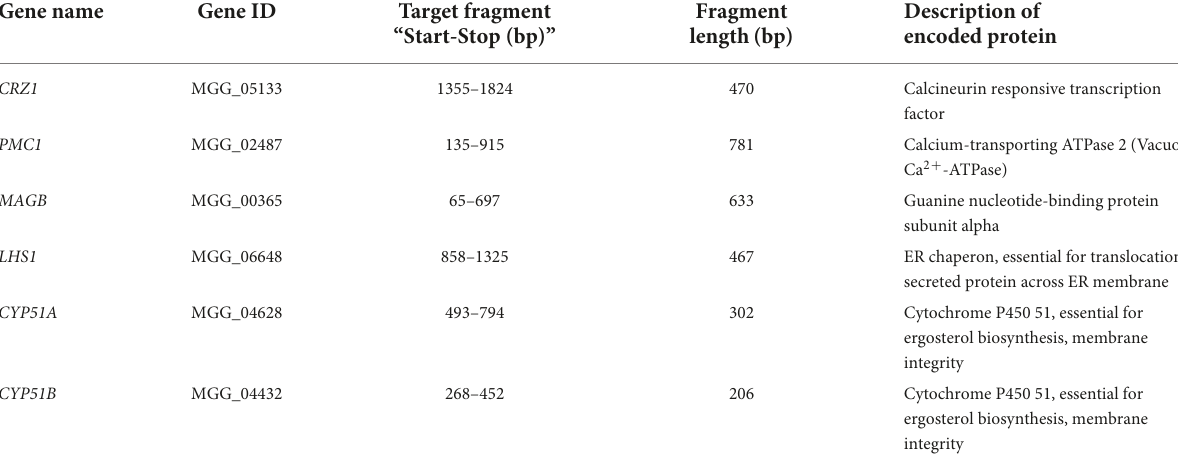
TABLE 1 Candidate host-induced gene silencing (HIGS) genes of Magnaporthe